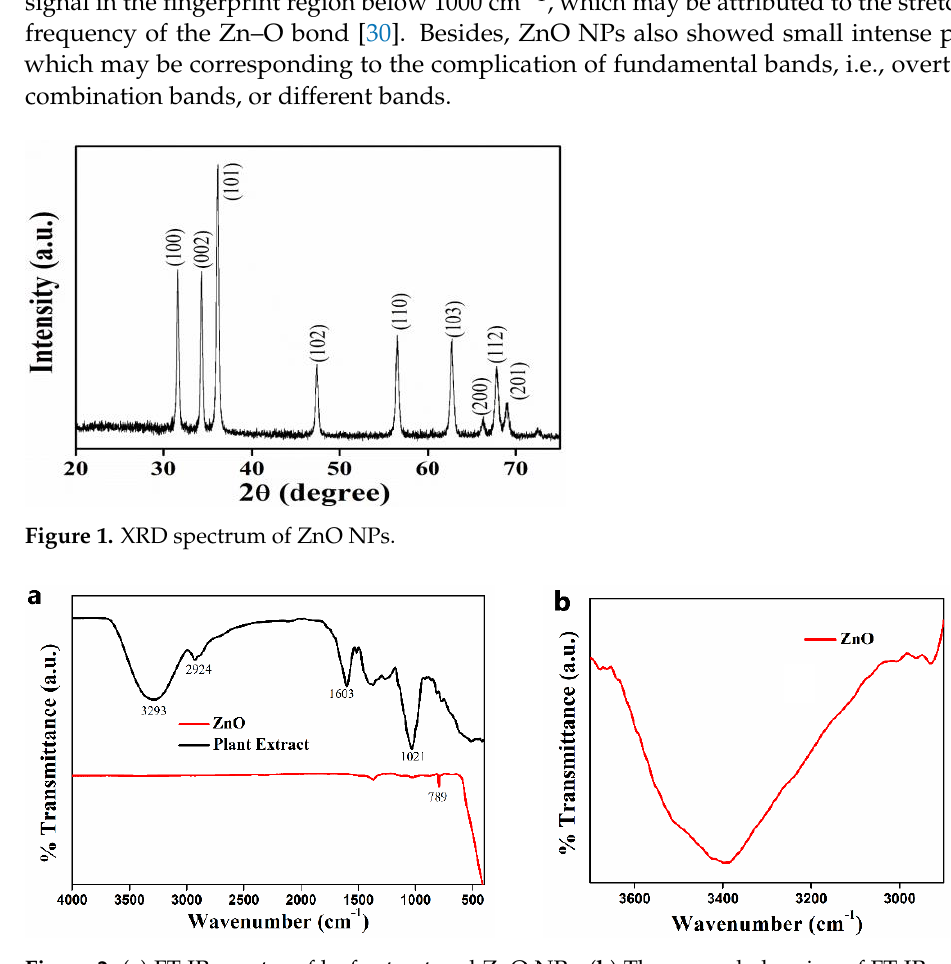
Figure 1. XRD spectrum of ZnO NPs.